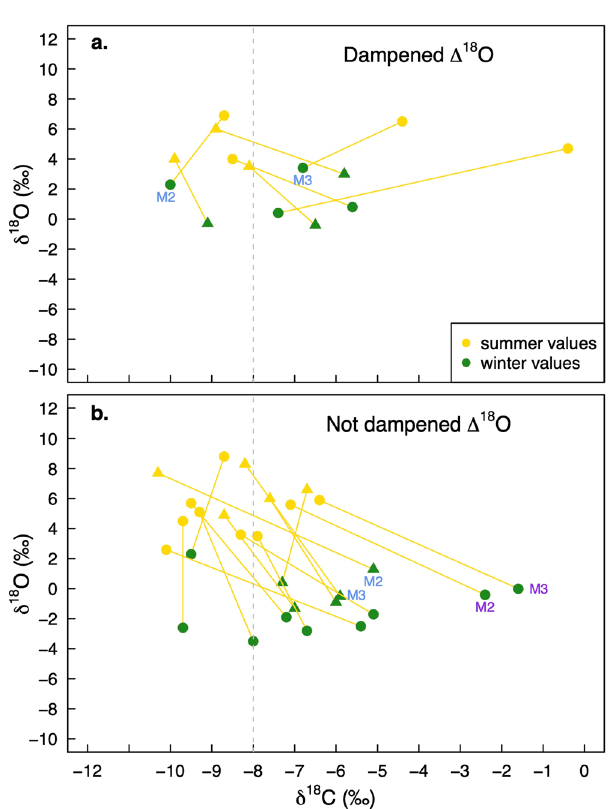
Figure 4. Matching summer and winter δ 13 C and δ 18 O values of all individuals. Seasonality was determined using δ 18 O max values for summer and δ 18 O min values for winter for each individual. M2 and M3 labels of matching colours denote the same individuals. Individuals were divided into groups based on the amplitude of intra-tooth δ 18 O variation ( Δ 18 O). ( a ) Dampened Δ 18 O (below 4.5‰), ( b ) Not dampened Δ 18 O (above